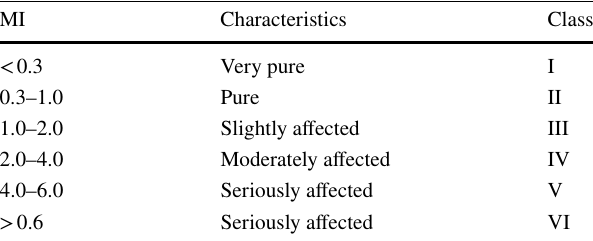
Table 4 Classification of water quality based on the metal index